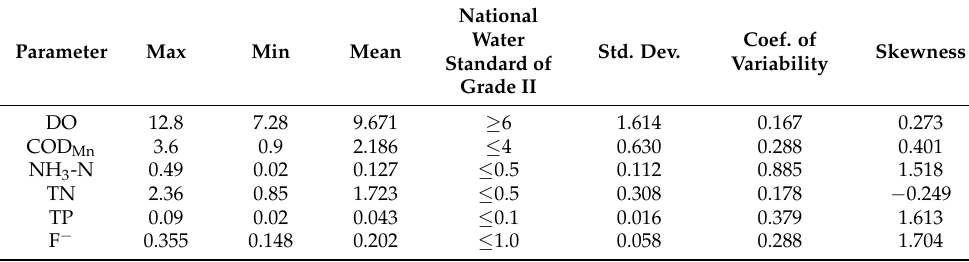
Table 3. Statistical description of upstream water quality indicators (concentration units in mg/L).